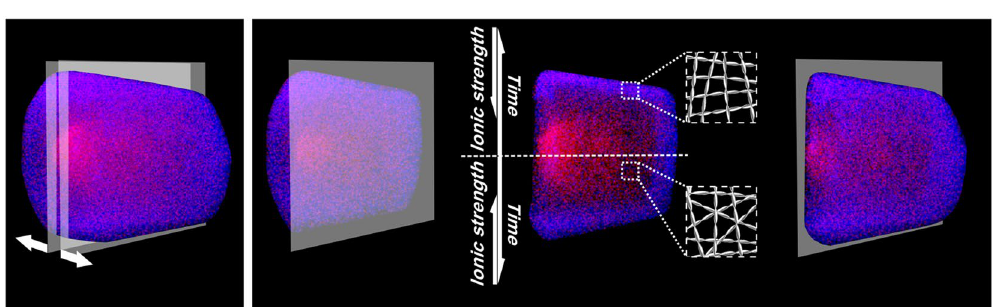
Figure 5. Artistic impression on the internal architecture of SFAs formed at initial ionic strength of 2mM CaCl 2 . ( A ) A 3D CLSM image of a SFA. ( B ) Proposed fibril organization mapped on a lateral slice of the SFA. In time, new sections of the SFA are formed while the “effective” ionic strength is reduced due to the recruitment of counterions by the fibrils incorporated in the